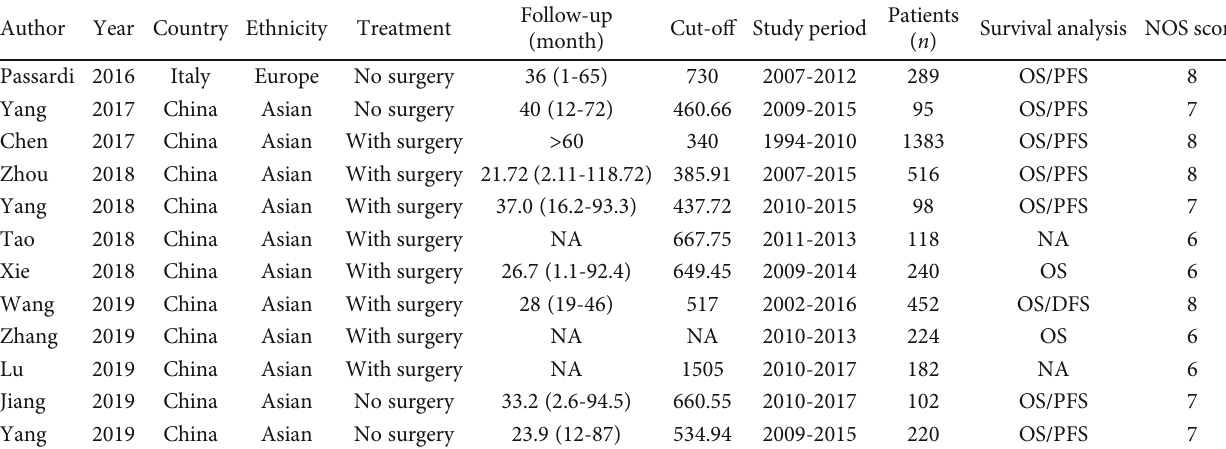
Figure 1: The fl owchart for literature screening. Table 1: Characteristics of all the studies included in the